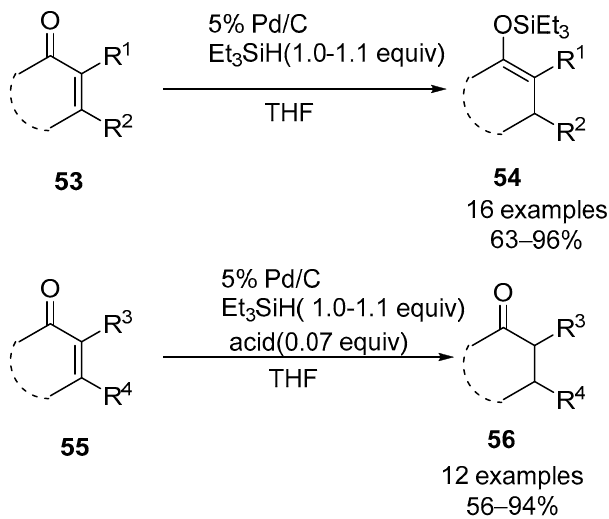
Scheme 7. Reduction of α , β -unsaturated aldehydes or ketones by Pd/C catalysis.